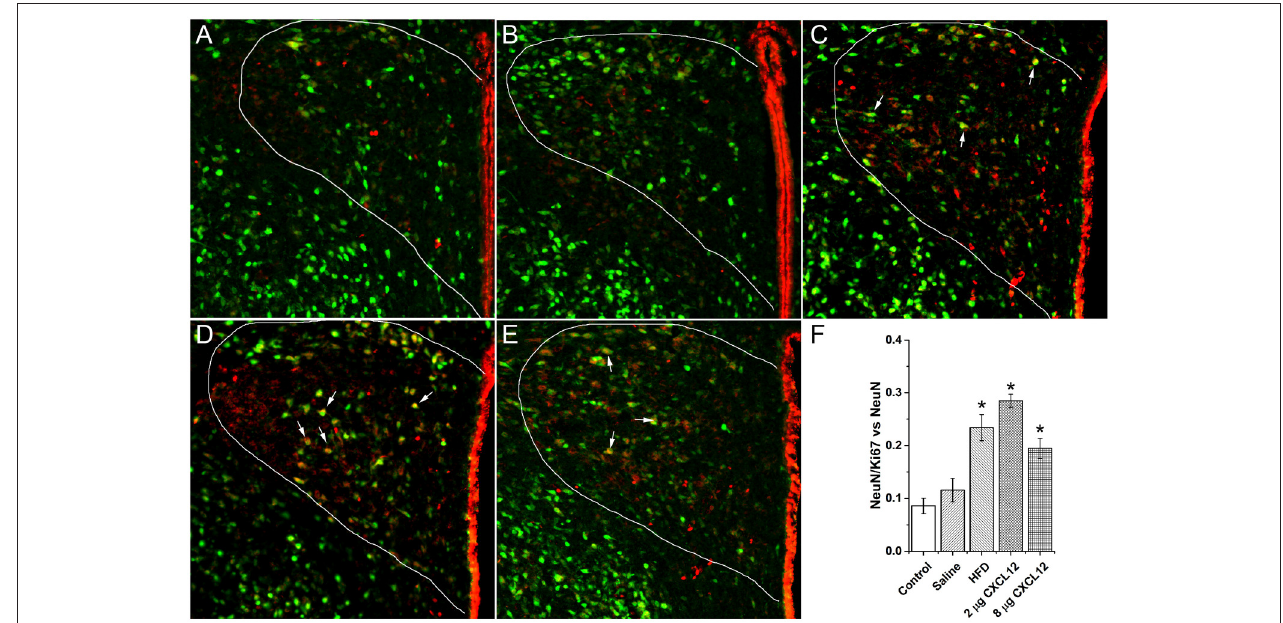
FIGURE 4 | Prenatal HFD and CXCL12 increased neurogenesis in the PVN. Representative photomicrographs of neurons double-labeled with NeuN and Ki67 from the PVN of P15 offspring under the following prenatal conditions: (A) negative control rats; (B) saline injected rats; (C) HFD exposed rats; (D) 2 µ g CXCL12 exposed rats; and (E) 8 µ g CXCL12 exposed rats. The white arrows depict neurons positive for both NeuN and Ki67. (F) Prenatal exposure to a HFD, 2 or 8 µ g CXCL12, significantly increased the number of double-labeled NeuN/Ki67 neurons as compared to control. * p < 0.05 vs. control.